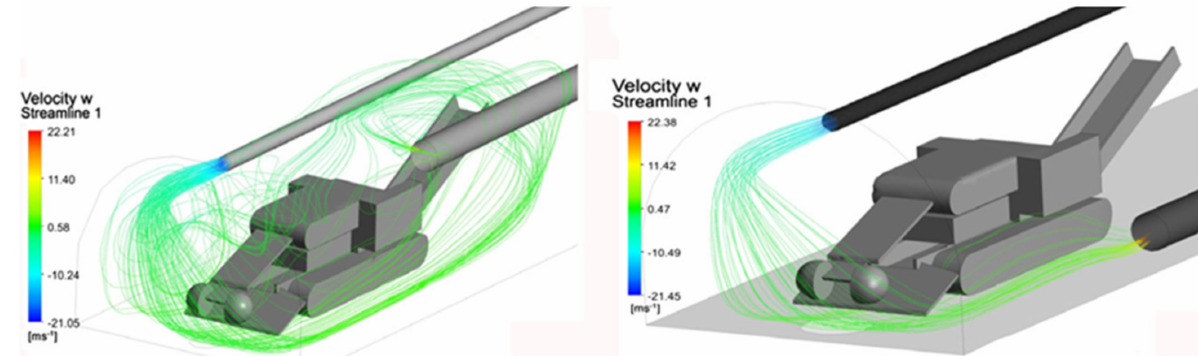
Figure 1. Visualization of the air flow velocity in the face of the mine heading. Reprinted with permission from ref. [14] Copyright 2011